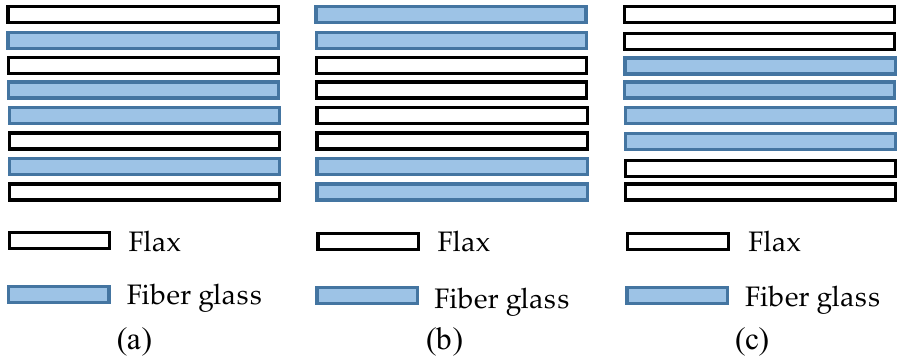
Figure 3. ( a ) The intercalation stacking sequence, ( b ) the sandwich-like stacking sequence with glass fiber as the outmost layer, and ( c ) The sandwich-like stacking sequence with flax fiber as the outmost layer.